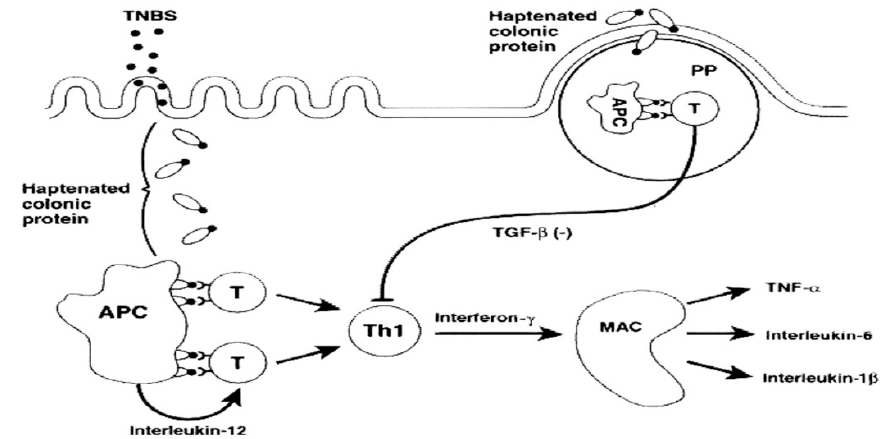
Figure 2. Mechanism of action of 2,4,6-trinitrobenzenesulfonic acid (TNBS). Inducing experimental colitis [40].